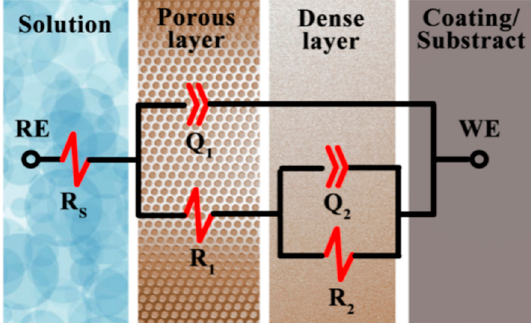
Figure 7. Electronic equivalent circuit applied to fit the electrochemical impedance spectroscopy data of the samples.